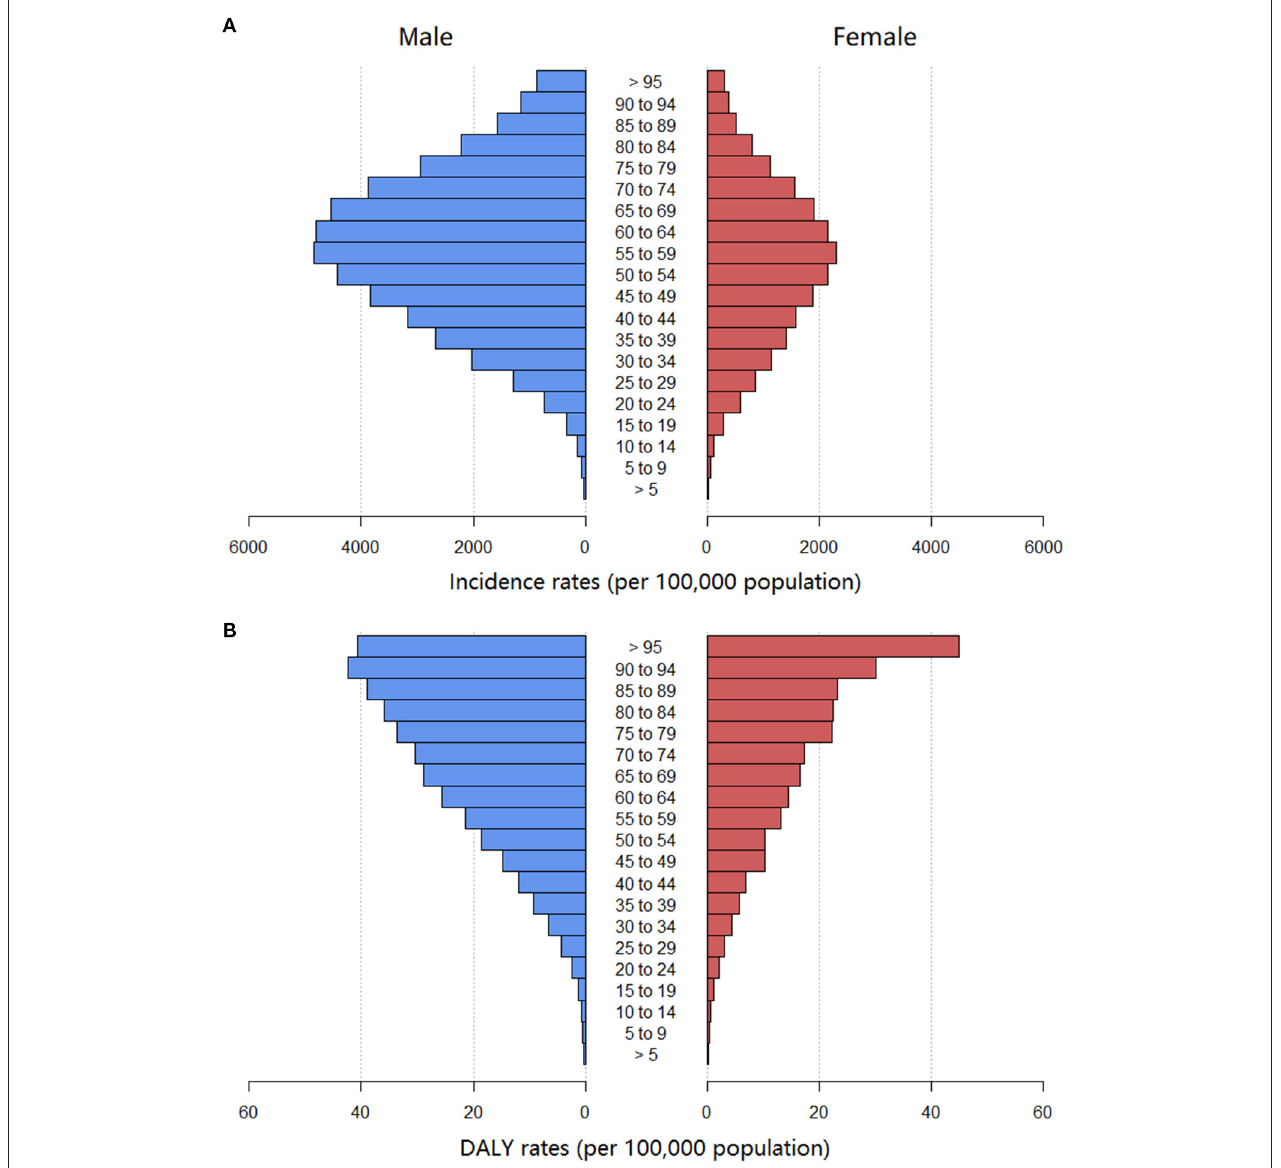
FIGURE 2 | The age-standardized incidence rate (A) and DALYs rate (B) of urolithiasis of different age groups globally. DALYs, disability-adjusted life